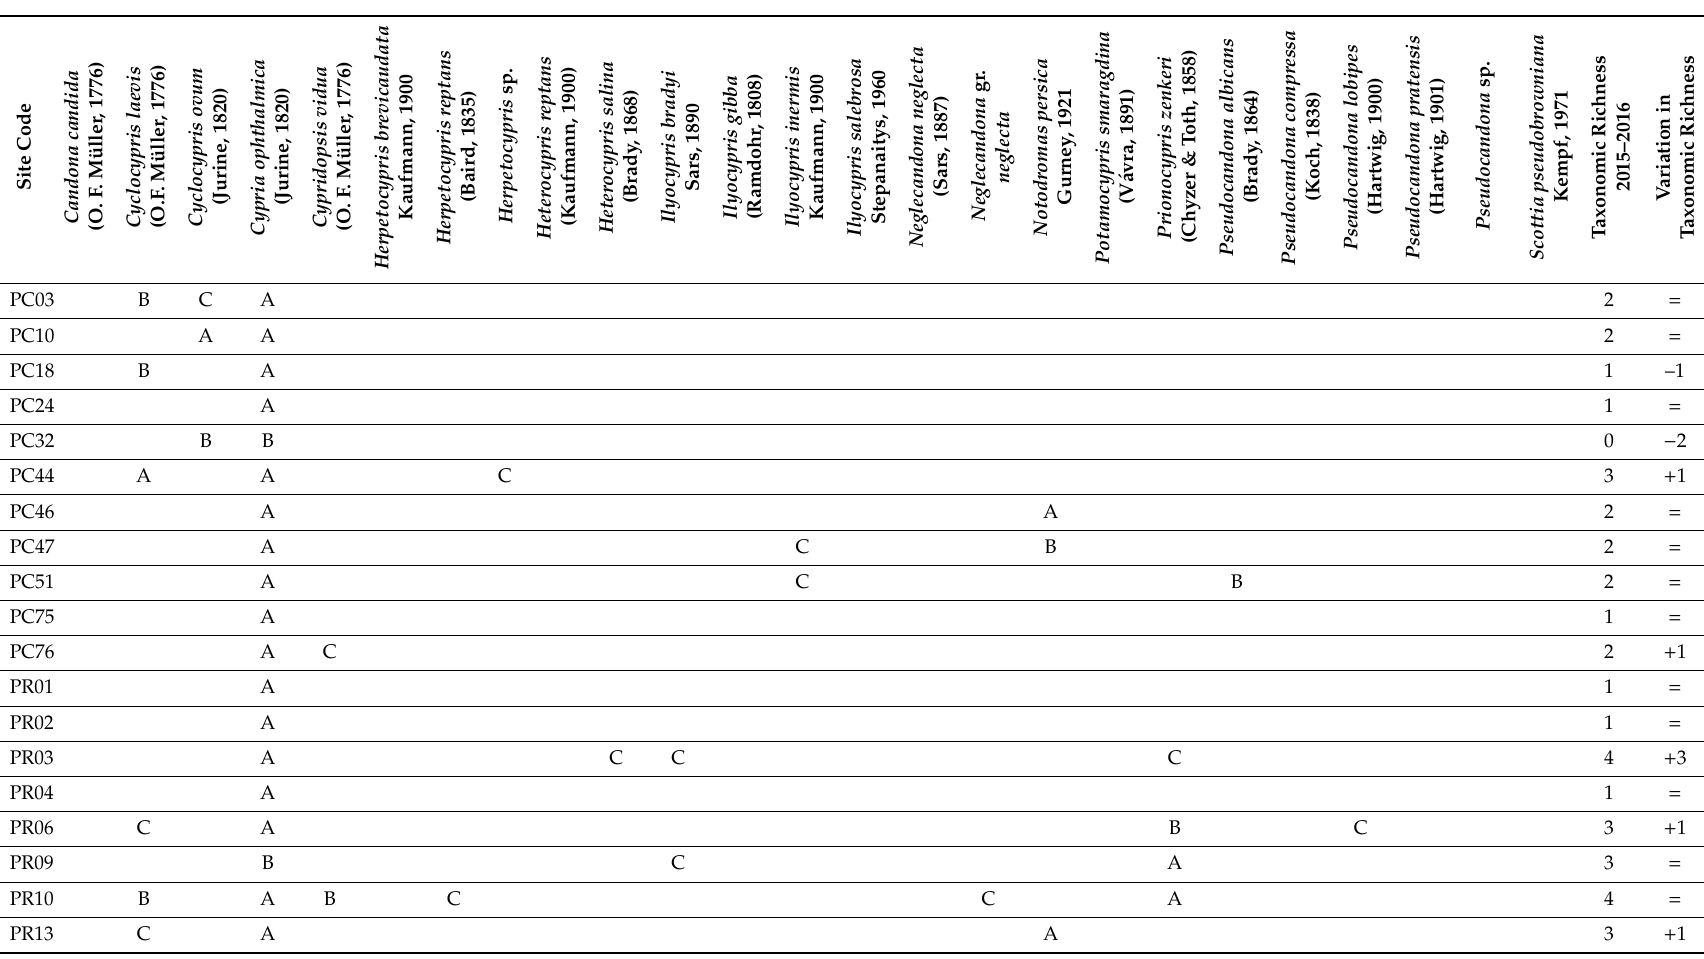
Table 2. Comparison between ostracod assemblages found in 2015–2016 and in previous studies [10,15] in each sampling site. A: taxa recorded in all surveys; B: taxa absent in 2015–2016 but encountered in previous surveys; C: taxa found in 2015–2016 but absent in previous surveys. Σ : number of total records for each taxon in